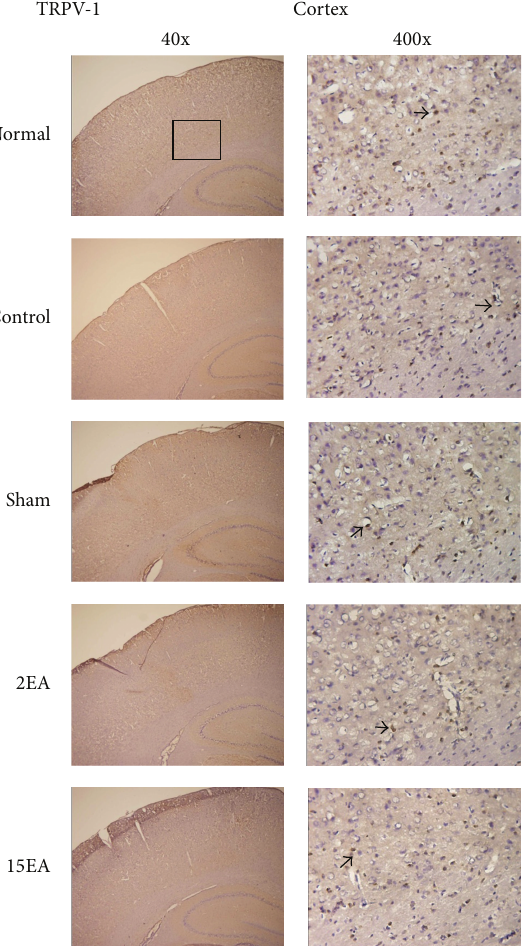
Figure 3: Effect of EA on cortical TRPV1 immunostaining posi- tive cells in SD rats with CCI-induced neuropathic pain. TRPV1 immunostaining positive cells (arrow) in the cortex (Cortex) were similar among normal group (normal), control group (control), sham group (sham), 2EA group (2EA), and 15EA group